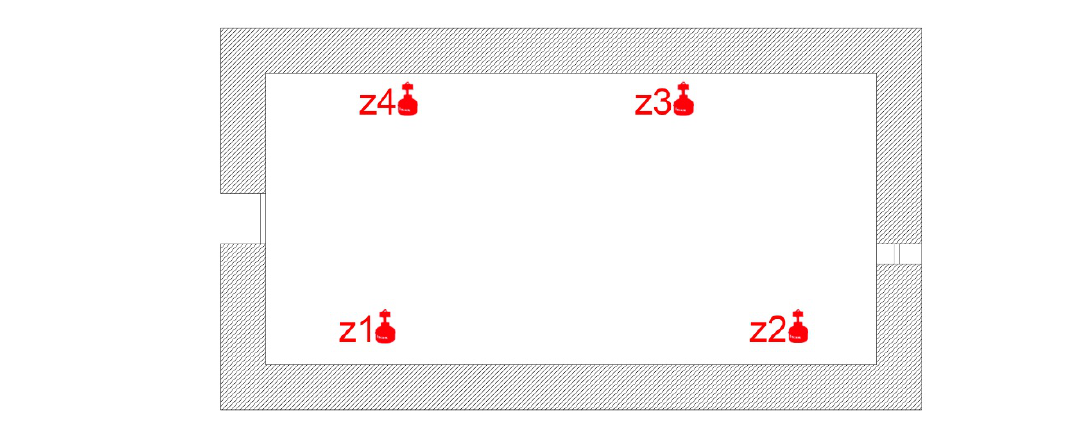
Figure 13. Plant of the Ereta powder keg with the layout of the measurements made in the